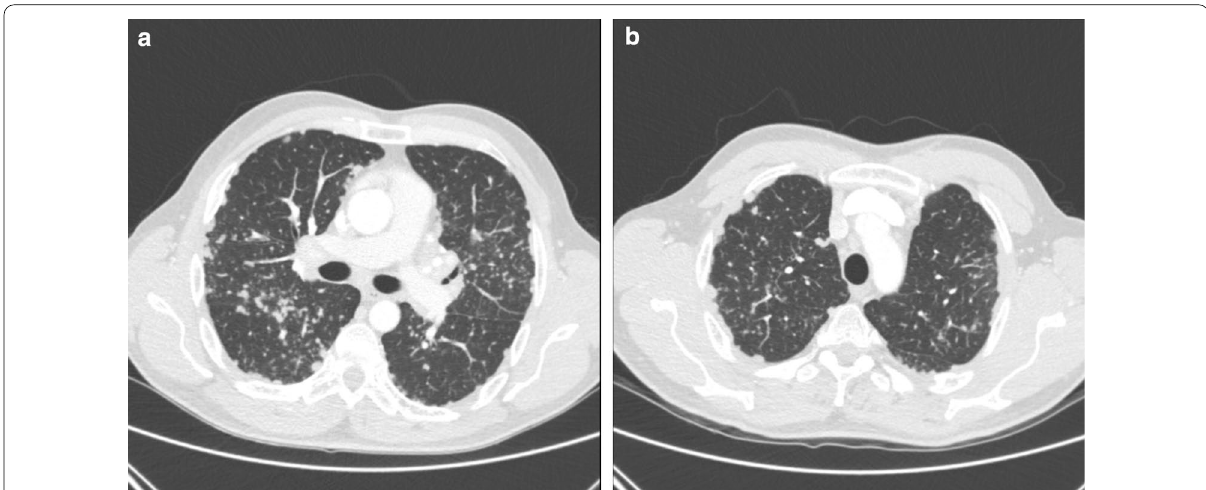
Fig. 19 Diagnosis: pleural sarcoidosis. Technique: axial contrast-enhanced chest CT. Description: A 50-year-old man was referred for a chest CT as part of an investigation for shortness of breath. The axial contrast-enhanced CT in lung window settings ( a , b ) shows extensive bilateral nodular pleural thickening with diffuse micronodules. Video-assisted thoracoscopy was performed and histopathologic examination showed findings consistent with pleural sarcoidosis